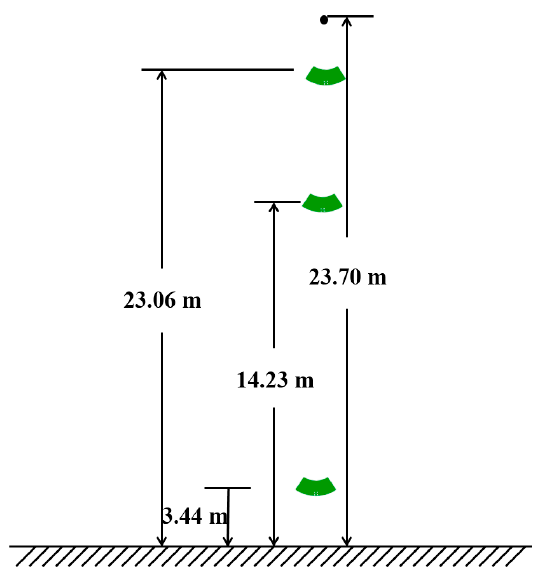
Figure 8. Schematic of the installation location of the 220 kV transmission line sensors.